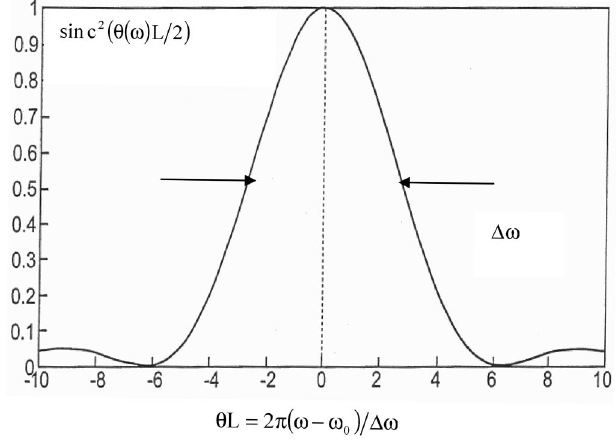
FIG. 4. The spectral energy line-shape function of radiation from an oscillating electron emitting a wave packet of finite . For PB-FEL, see duration t s